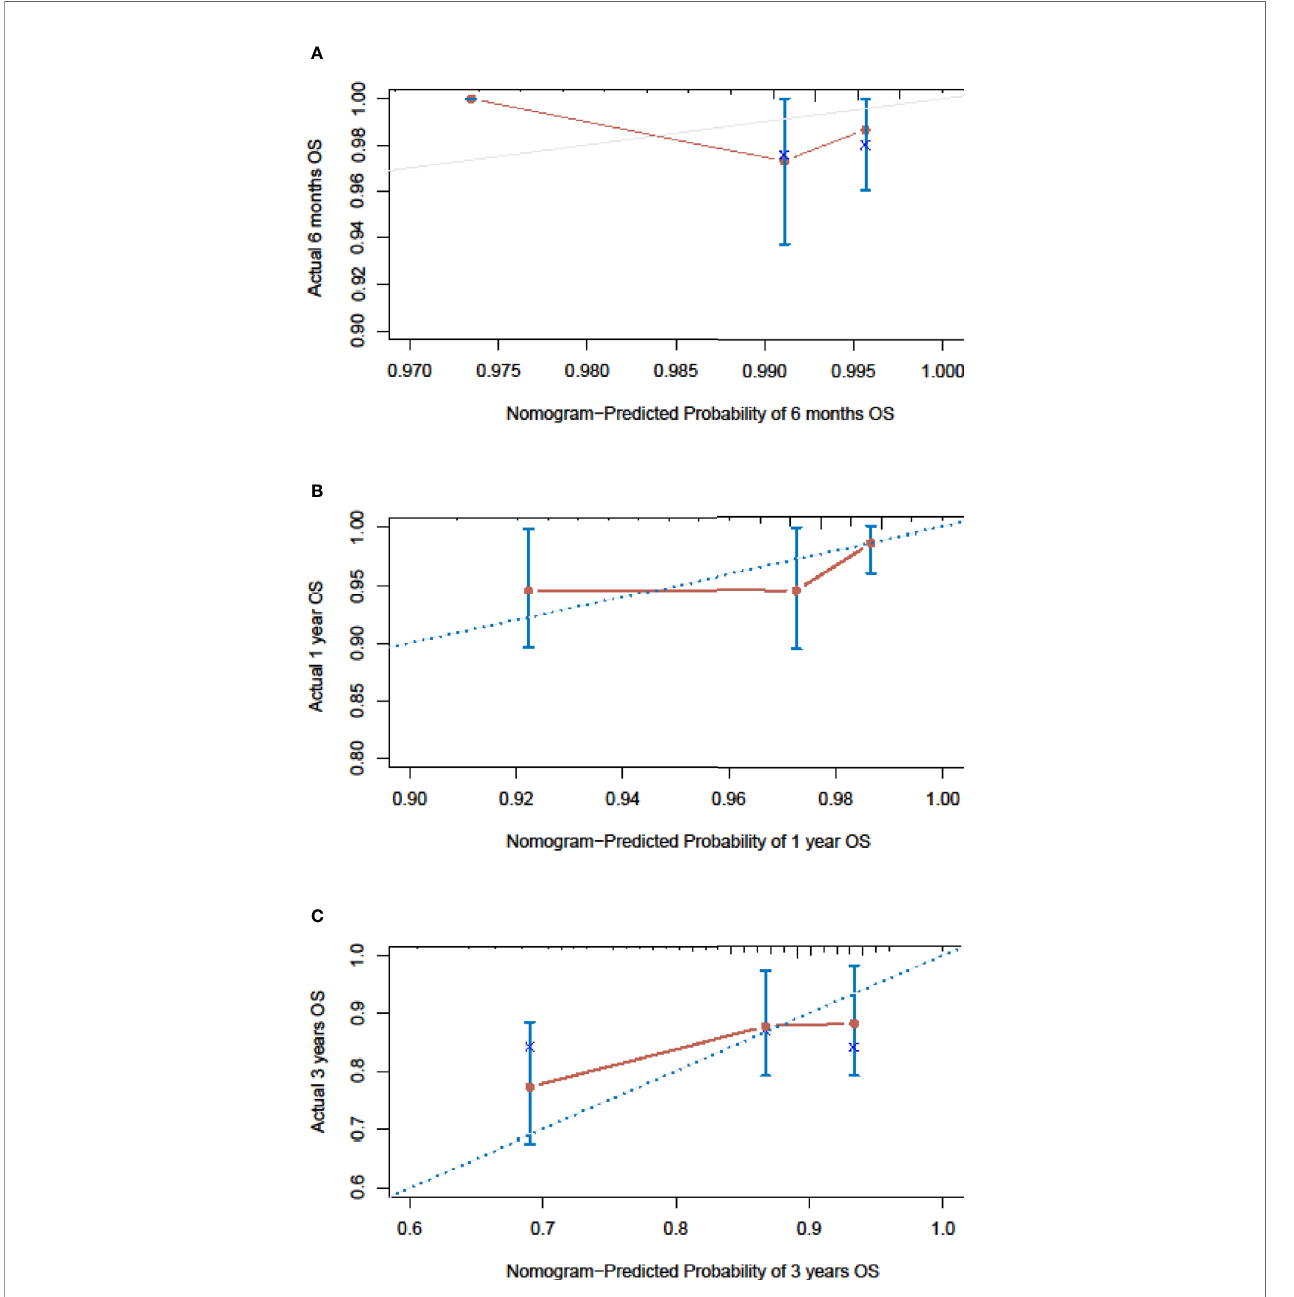
FIGURE 4 | Nomogram calibration curves for the validation cohort. The calibration curves of the model for d 6-month (A) , 1-year (B) and 3-year (C) of overall survival in the validation